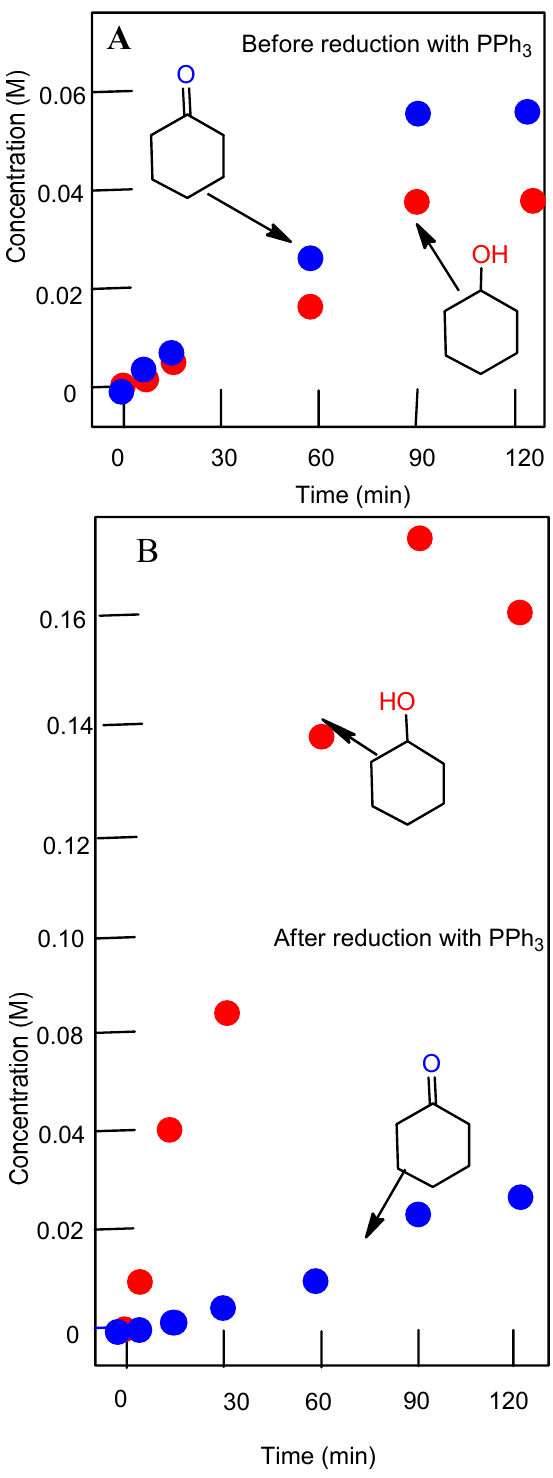
Figure 5. Accumulation of cyclohexanol and cyclohexanone in the oxidation of cyclohexane (0.46 M) with H 2 O 2 (2.0 M) catalyzed by complex 2 (5 × 10 − 4 M) in the presence of PCA (2 × 10 − 3 M), at 50 ◦ C in acetonitrile. Concentrations of products were measured by GC before ( A ) and after ( B ) the reduction of the reaction samples with solid PPh 3